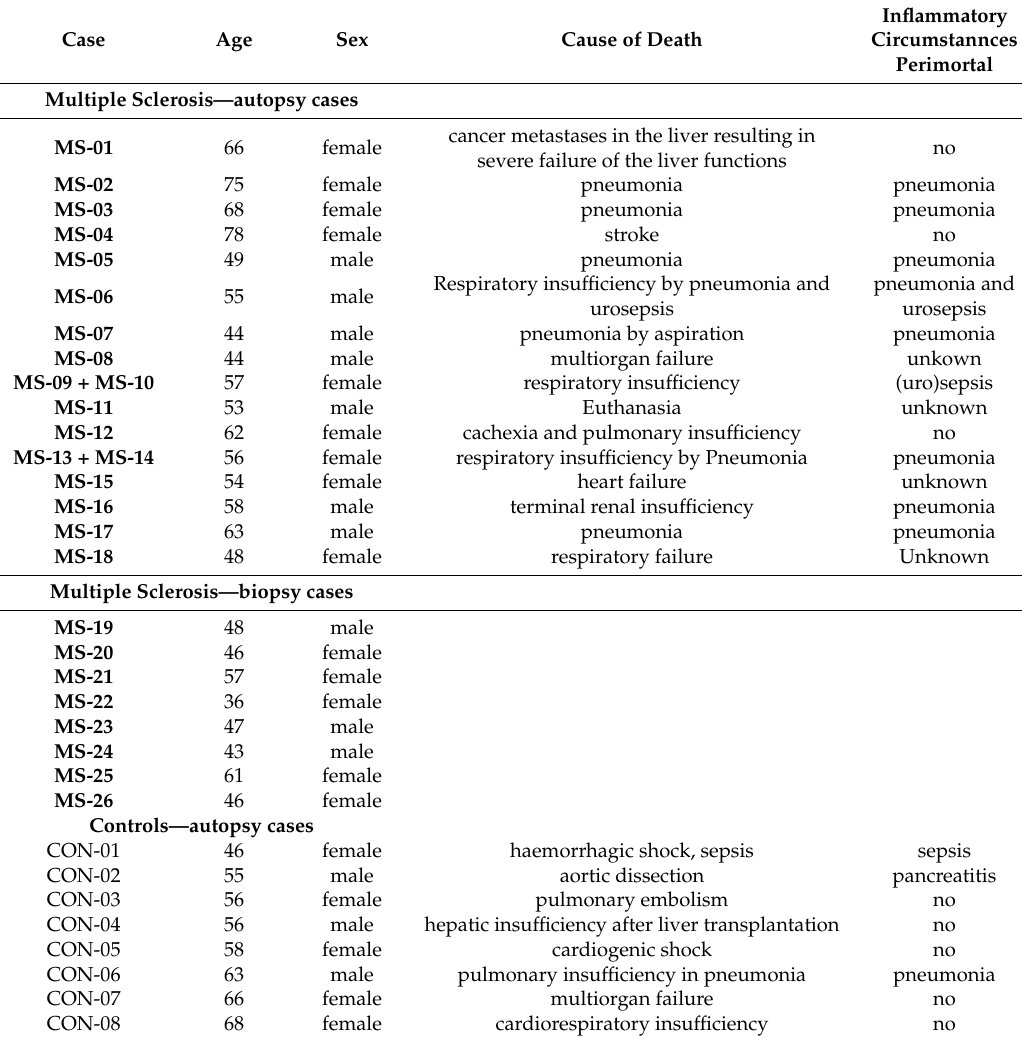
Table 1. MS autopsy cases and